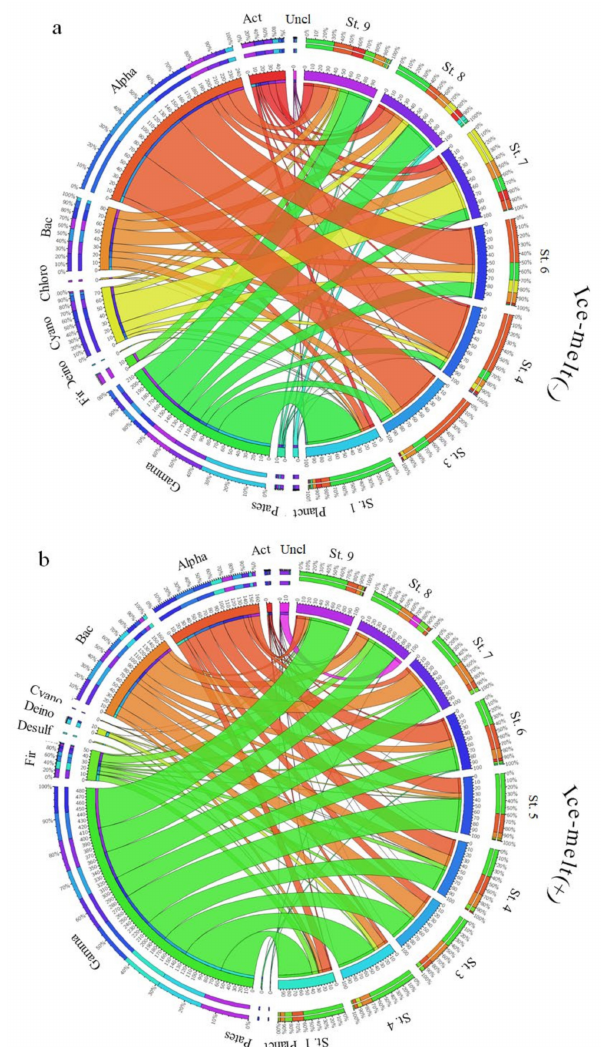
Figure 4. Circle tables evidencing phylogenetic groups detected at each sampling site during Ice-melt ( − ) ( a ) and Ice-melt (+) ( b ) seasons in the Pasvik